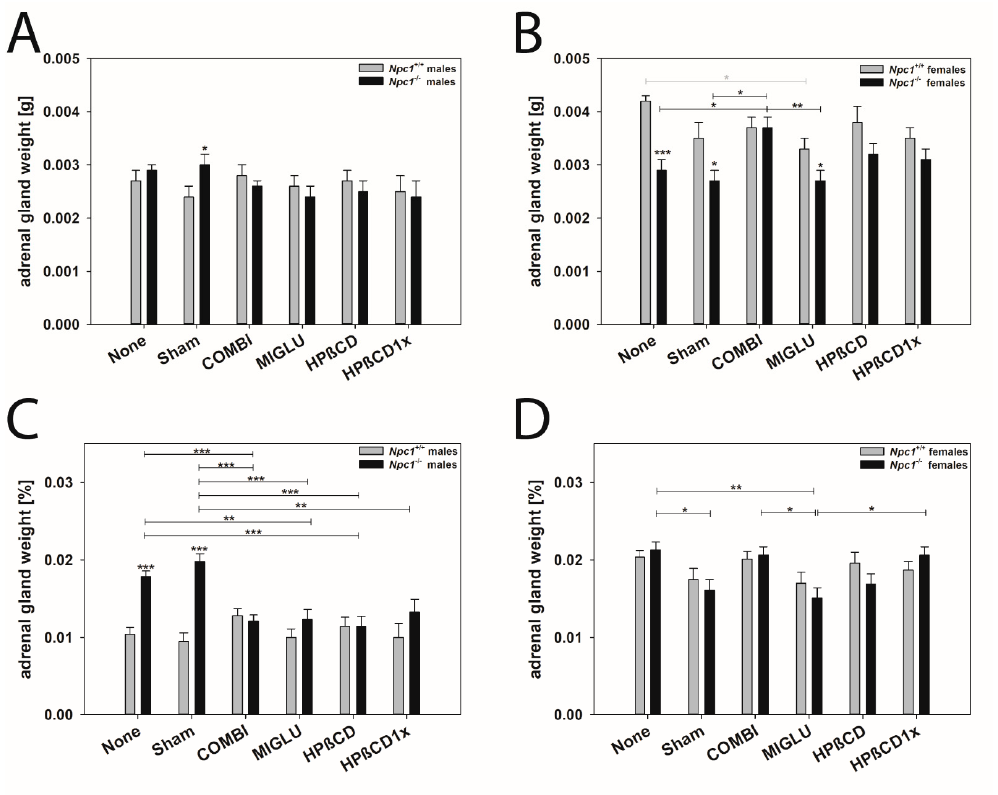
Figure 7. Adrenal gland weight ( A , B ) and relative adrenal gland weight ( C , D ) of Npc1 mice. Male ( A , C ) and female ( B , D ) mice. Significant post-hoc tests are indicated by asterisks (* p < 0.05, ** p < 0.01, *** p < 0.001). Data are means ± SEM.